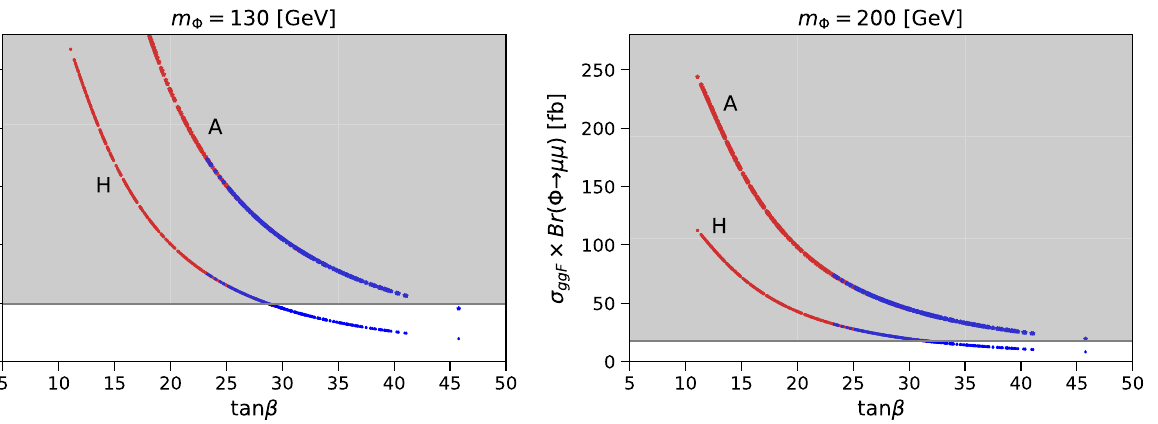
Fig. 7 Thegluonfusionproductioncross-sectiontimesbranchingratio into μ + μ − as a function of tan β , in the case quarks couple to (cid:5) 2 , for a light neutral Higgs boson m φ = 130 GeV and m φ = 200 GeV. The